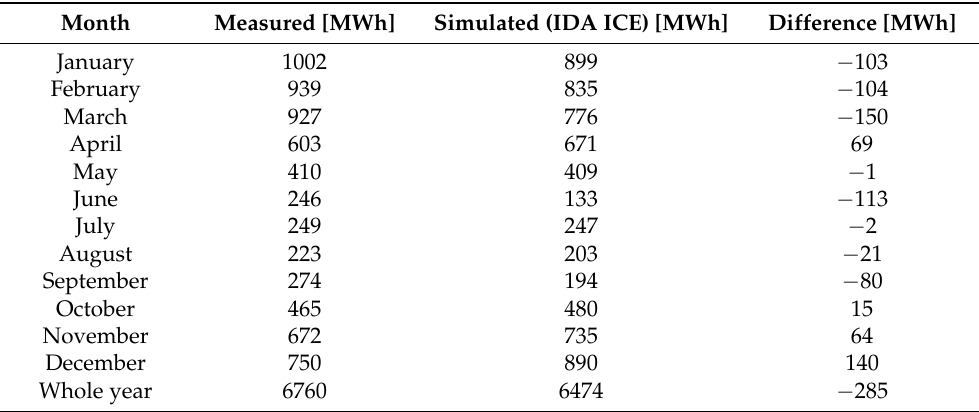
Table 2. Corrected simulated monthly energy consumption data from IDA ICE is compared to the measured data from 2020. The simulated values are corrected to represent the year 2020 through the heating degree days correction. The data are used for the validation of the energy consumption